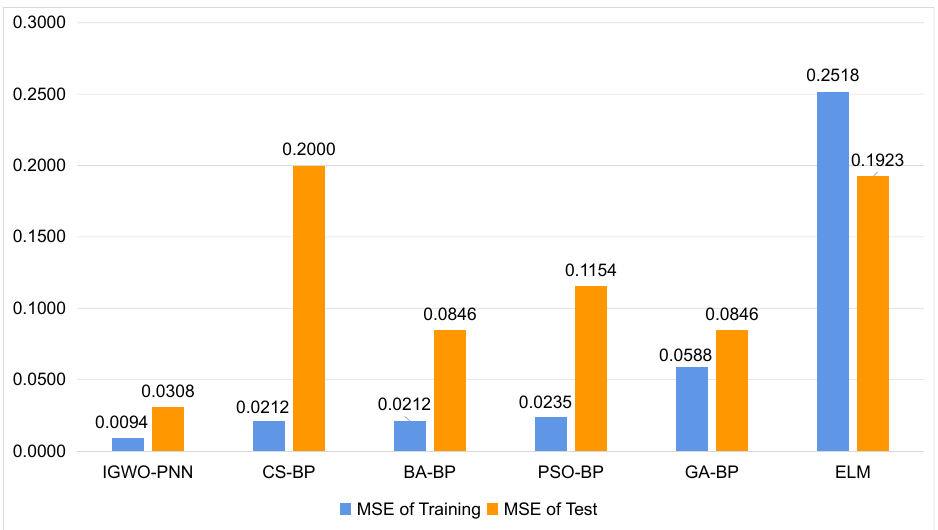
Figure 12. Comparison of the MSE of the third set of comparison experiments.